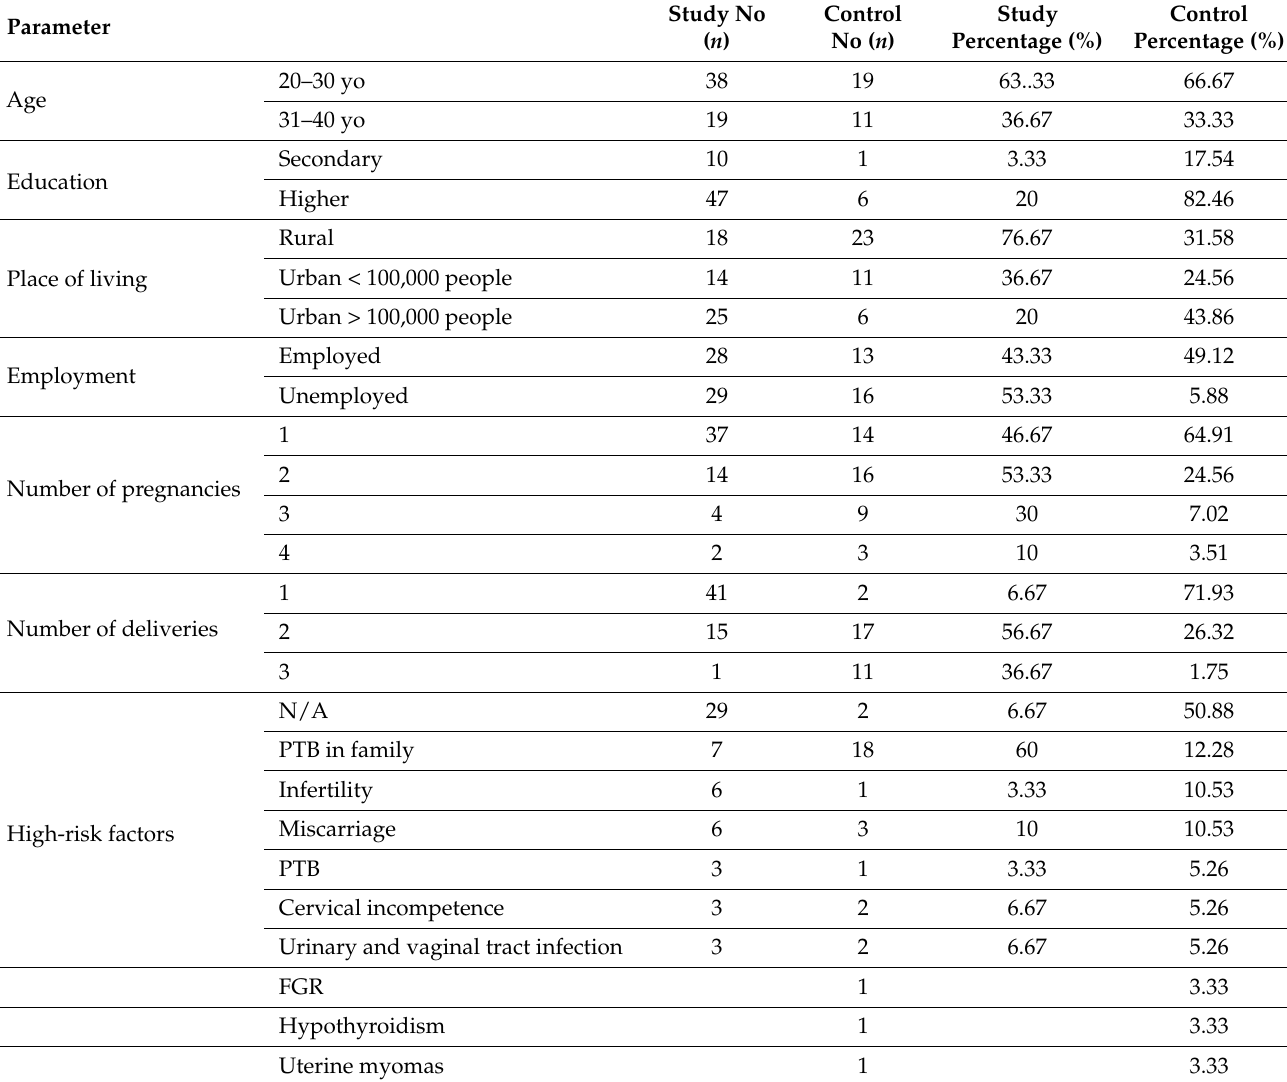
Table 1. Demographic, socio-clinical characteristics of the study and control